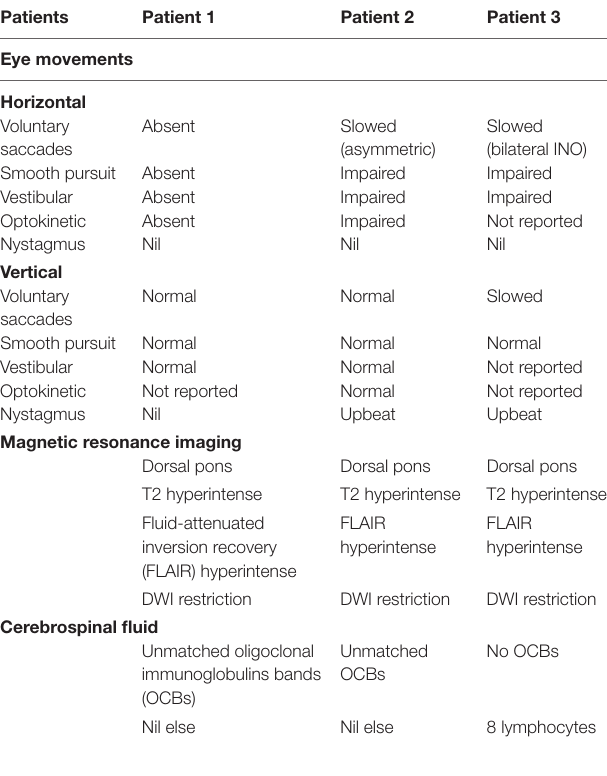
taBLe 1 | Summary of the clinical oculomotor findings, MRI imaging findings and CSF